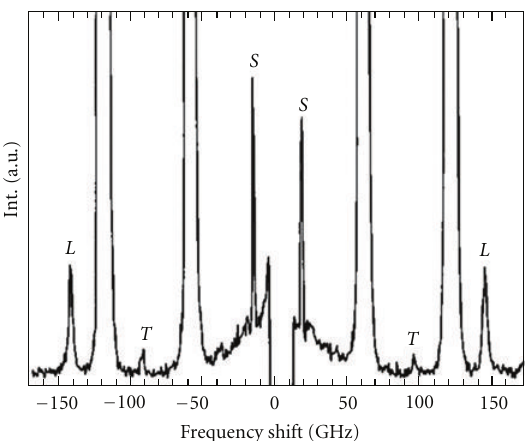
Figure 13: The Brillouin spectrum of bulk Si showing a broad quas- ielastic peak around the central elastically scattered peak. The peaks labeled ( S ), ( T ), and ( L ) correspond to the surface acoustic wave, transverse mode ( T ), and longitudinal mode ( L ), respectively